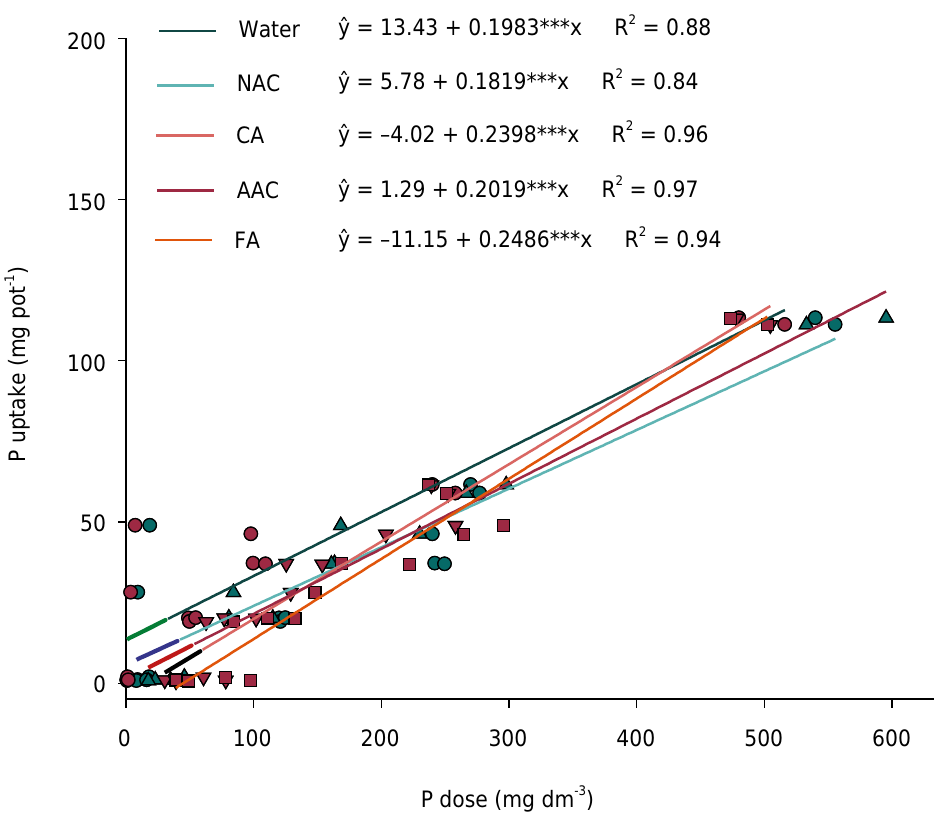
Figure 3. Phosphorus accumulation by corn as a function of P doses and P extractors (water; NAC, neutral ammonium citrate; CA, citric acid; AAC, acid ammonium citrate pH 3; FA, 2 % formic